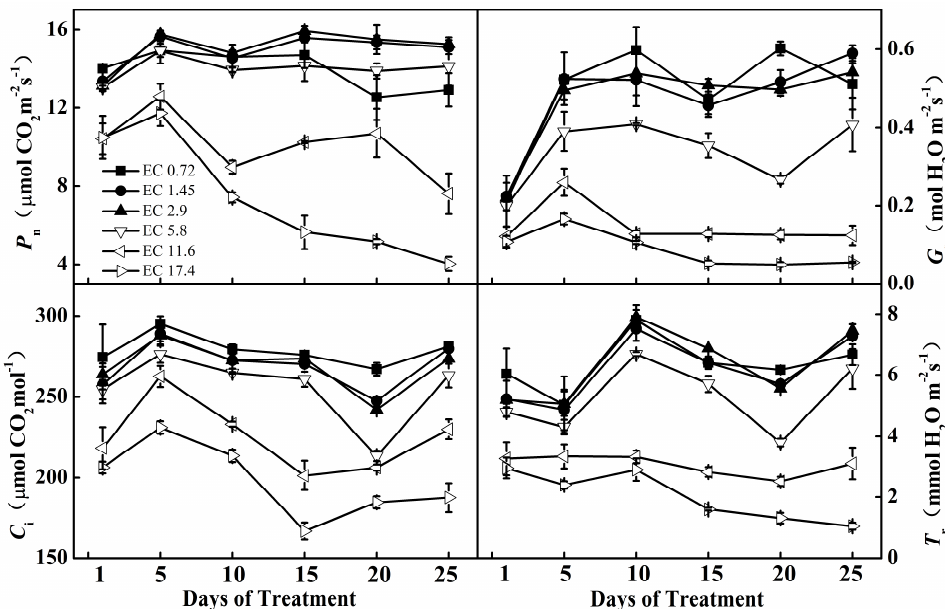
Figure 2. Effects of different EC treatments on the net photosynthetic rate ( P n ), stomatal conductance ( G s ), intercellular CO 2 concentration ( C i ), and transpiration rate ( T r ) after 1 d, 5 d, 10 d, 15 d, 20 d, and 25 d of treatment. Data are the means of at least three biological replications. EC0.72, EC1.45, EC2.9, EC5.8, EC11.6, and EC17.4 represent the different nutrient solution electrical conductivities of 0.72 dS m −1 , 1.45 dS m −1 , 2.9 dS m −1 , 5.8 dS m −1 , 11.6 dS m −1 , and 17.4 dS m −1 . 2.3. Analyses of the Contents of Leaf Chlorophyll (Chl) and Carotenoids (Car)